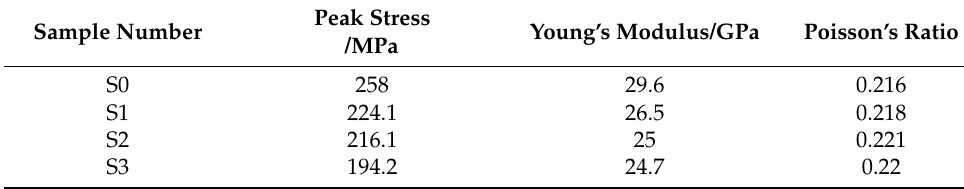
Table 2. Mechanical parameters of granite before and after chemical